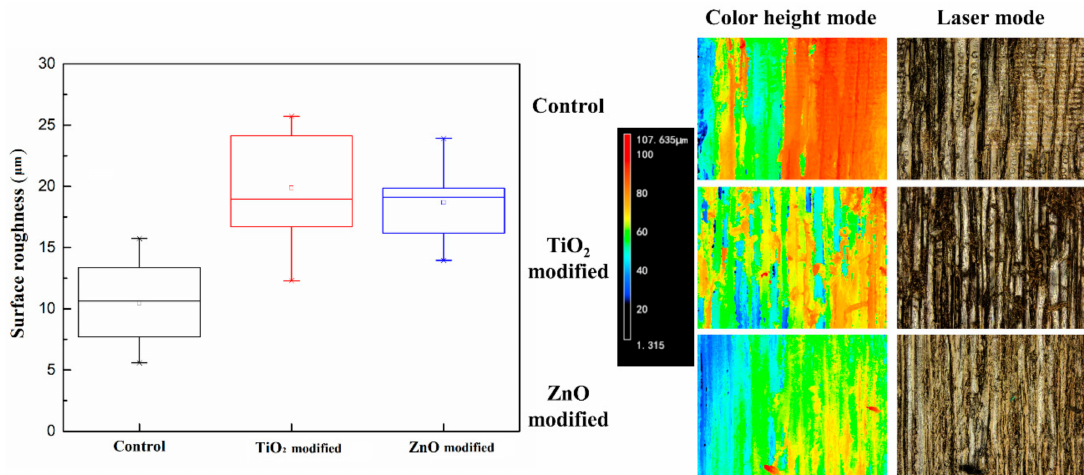
Figure 3. Roughness (Ra) of the wood samples before and after surface